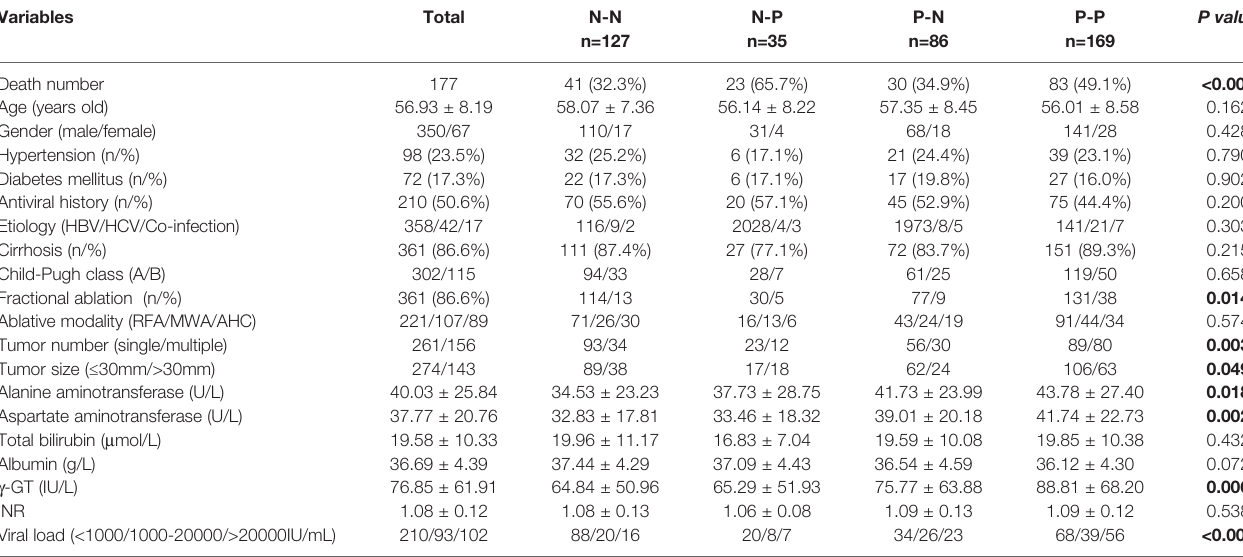
AFP, alpha fetoprotein; N-N, negative AFP at baseline and negative AFP at relapse; N-P, negative AFP at baseline and positive AFP at relapse; P-N, positive AFP at baseline and negative AFPatrelapse;P-P,positiveAFPatbaselineandpositiveAFPatrelapse;RFA,radiofrequencyablation,MWA,microwaveablation;AHC,argon-heliumknifecryoablation;INR,international normalized ratio. Bold values indicate that the P value is less than 0.05, there is statistical difference.